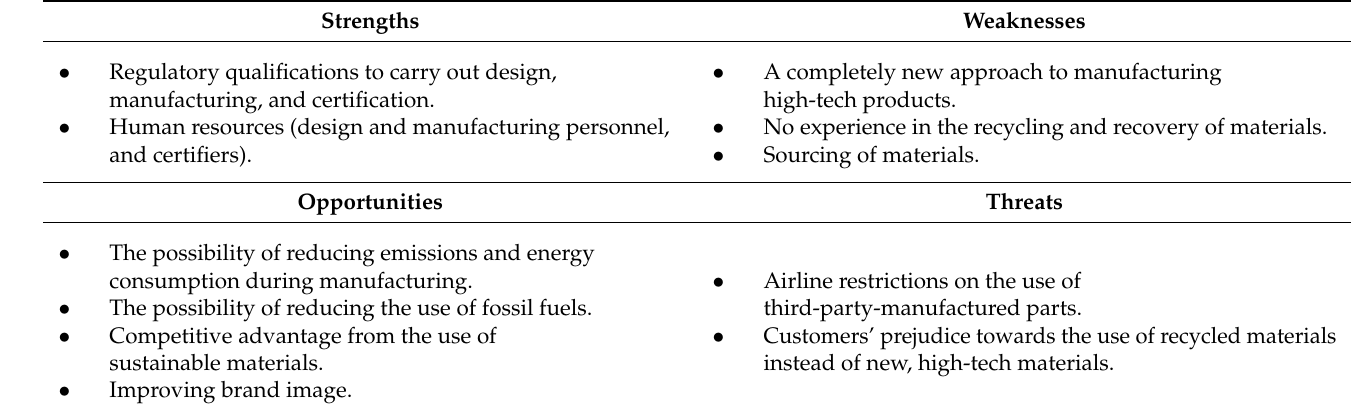
Table 2. SWOT analysis of a third-party manufacturer of parts made from recycled